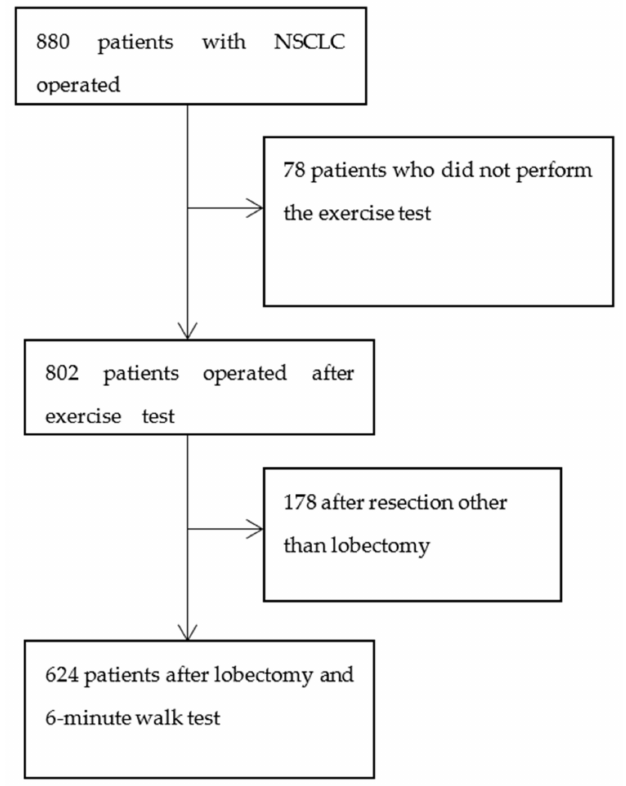
Figure 1. Study flow chart.